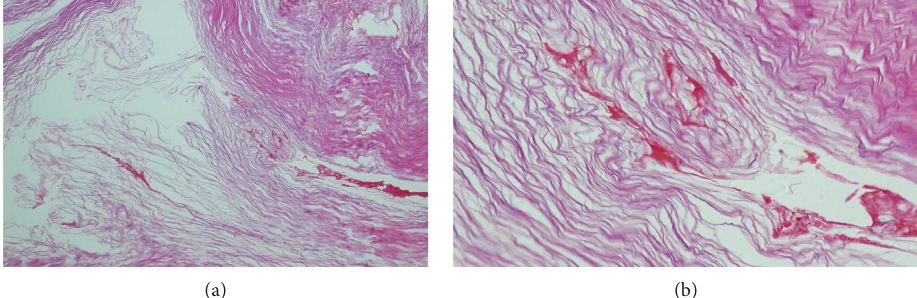
Figure 2: (a) Keratinous material (hematoxylin/eosin stain, × 100). (b) Acellular lamellated keratin flakes (hematoxylin/eosin stain, ×